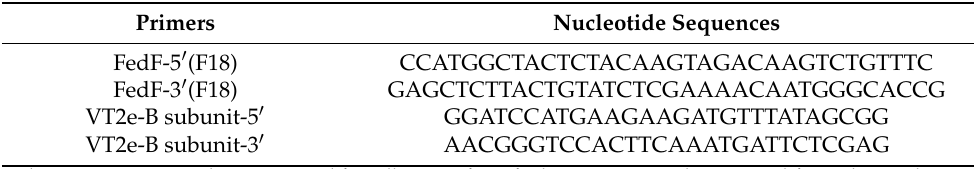
Table 1. Primer used for polymerase chain reaction